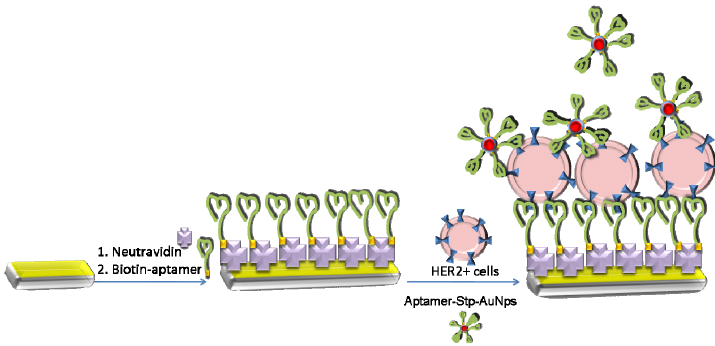
Figure 1. The scheme of the preparation of the aptasensor and binding of the cells at the aptamer surface. The gold nanoparticles modified by specific aptamers are used for the amplification of the cell detection.